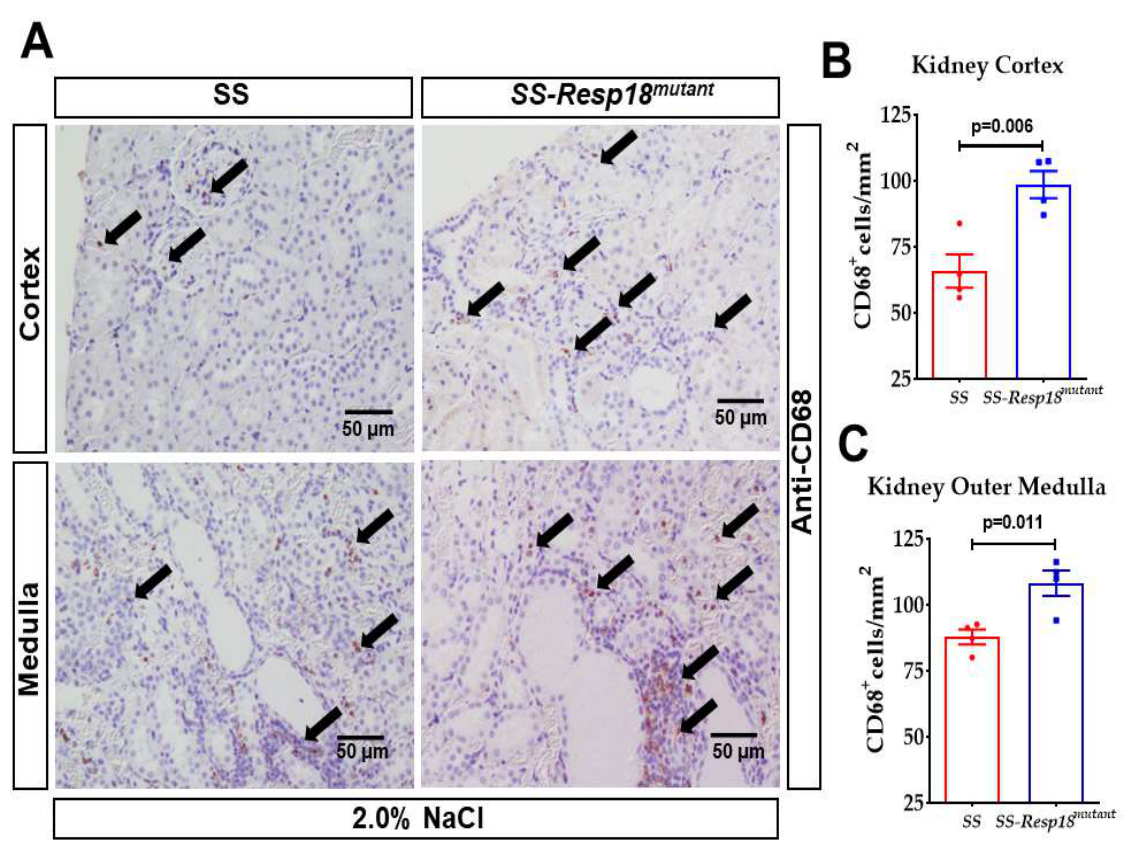
Figure 4. SS- Resp18 mutant rats have increased renal macrophage infiltration: ( A ) Representative images of renal sections probed with CD68 antibody and black arrows indicates positive staining for CD68, ( B ) kidney cortex, ( C ) kidney outer medulla ( n = 4). Graphs represent the quantification of the percent of the area with CD68 + macrophage infiltration. Data are mean ± SEM. p = 0.006, p = 0.011 vs. SS- Resp18 mutant , t -test.